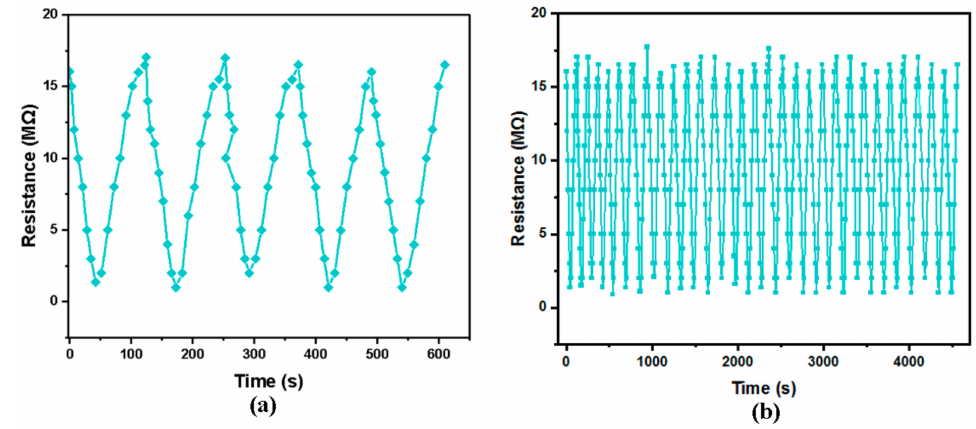
Figure 7. Graph of repeatability test of the sensor while working at the interval of 35–100% RH (from 35% RH to 100% RH and then 100% RH to 35% RH). ( a ) For five cycles, ( b ) for 50